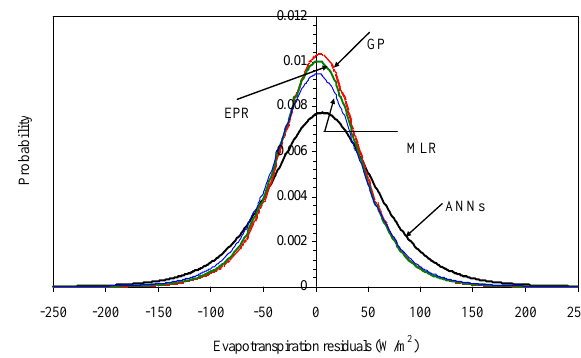
Table 9. The p -values of the two samples K-S test on the